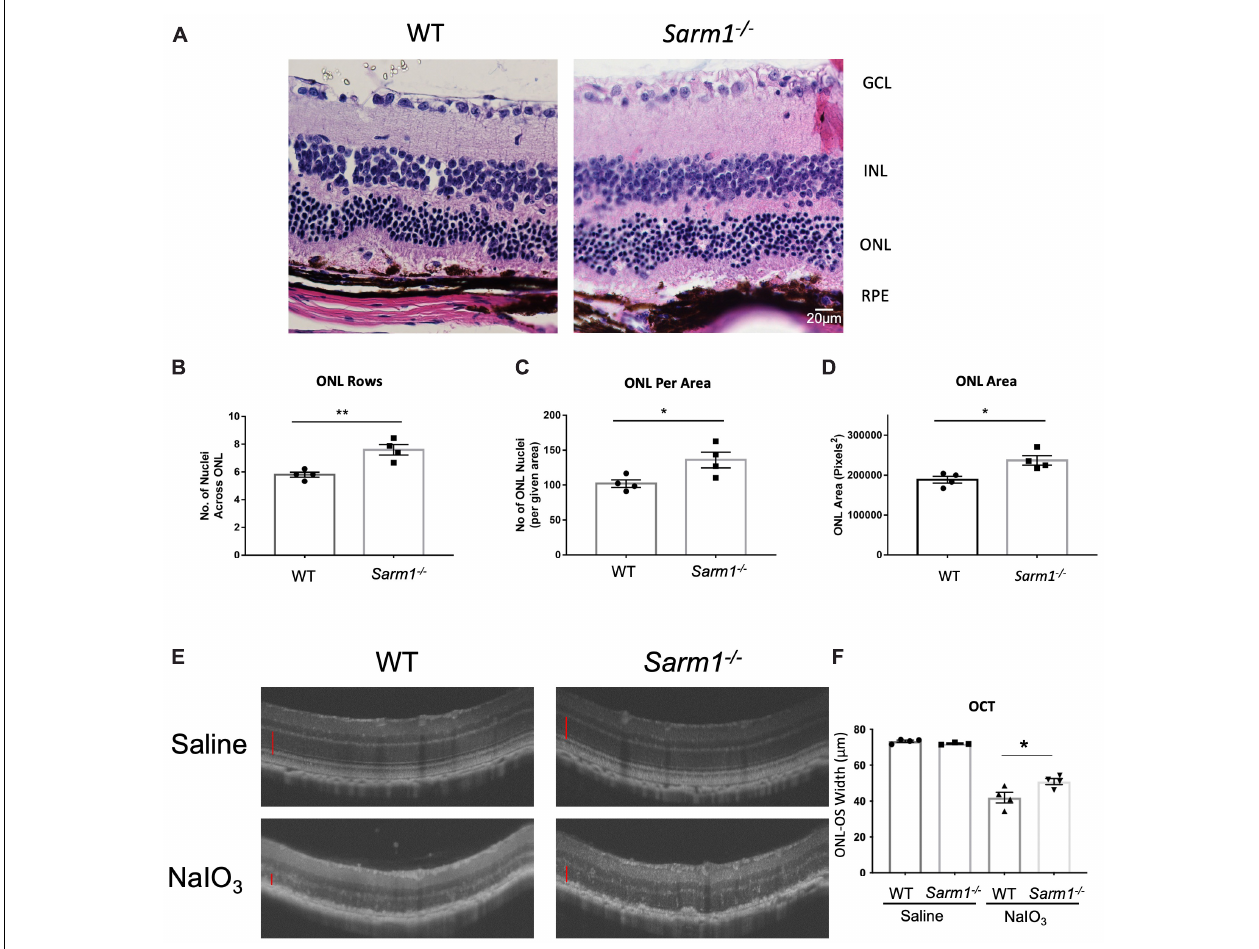
FIGURE 3 | Loss of SARM1 preserves photoreceptor number and length in the NaIO 3 model of retinal degeneration, following severe RPE degradation. Representative images of paraffin embedded retinal sections from WT and Sarm1 − / − mice 7-days post administration of NaIO 3 stained with haematoxylin & eosin (H&E) (A) . Quantification of the number of nuclei per ONL row (B) , number of nuclei in the ONL in an area of height 450 pixels in the centre of the ONL in each image (C) , and ONL area (D) (* P ≤ 0.05, ** P ≤ 0.01, n = 4 WT NaIO 3 mice, n = 4 Sarm1 − / − NaIO 3 mice). Optical coherence tomography (OCT) images taken in vivo from C57BL/6J and Sarm1 − / − mice 7-days post administration of NaIO 3 (50 mg/kg) (E) . Quantification of the distance of the ONL to the outer segments (OS) (marked with red line on OCT images) InSight (* P ≤ 0.05, by Student’s unpaired t test, n = 4 WT saline mice, n = 3 Sarm1 − / − saline mice, n = 4 WT NaIO 3 mice, n = 4 Sarm1 − / − mice) (F)